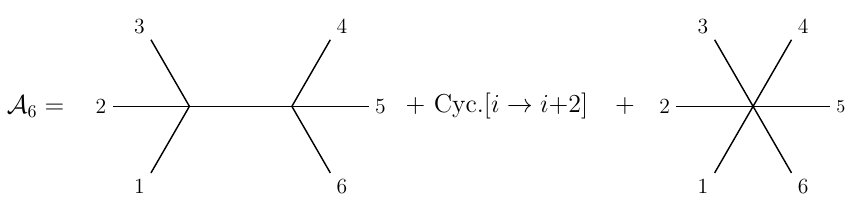
Figure 2 . Witten diagrams for the six-point NLSM amplitude. The exchange diagram is summed over the three inequivalent cyclic permutations.